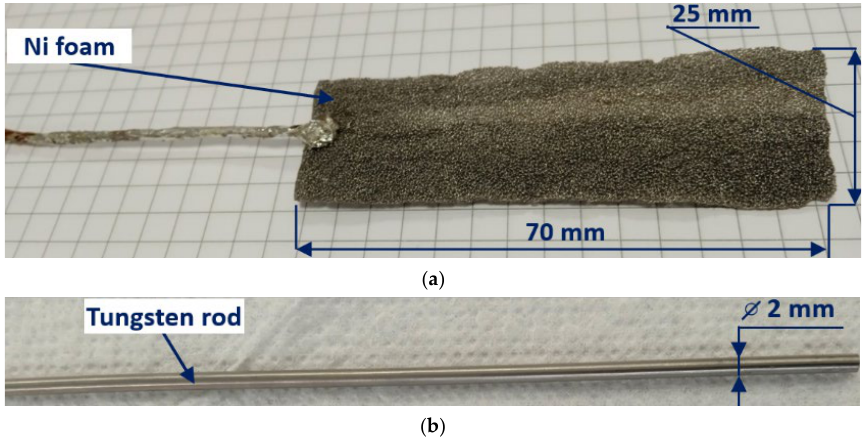
Figure 3. Ni foam anode ( a ) and tungsten cathode ( b ) used in the PDSE reactor. The DC voltage was supplied from the power source, which consisted of the LTC- 300-8D (Rucelf, Kolomna, Russia) variable autotransformer of 2.4 kVA nominal power equipped with a diode bridge and two smoothing capacitors of 16 mF (Kemet, Fort Lauderdale, FL, USA) providing the electrolytic cell with the rippled DC voltage. The instantaneous discharge voltage was measured using a WAD-A-MAX-608 (Acon, Lismore, Australia) voltage probe, while the instantaneous discharge current was measured using the voltage drop across a resistor of 1.5 mOhm using a WAD-A-MAX- 609 (Acon) precision isolation amplifier. All signals of the current and voltage probes were recorded using a WAD-AD12-128H (Acon) data logger. The data acquisition frequency was set at 100 kHz for each probe. The electric energy consumed by the autotransformer of the DC power supply was additionally measured by the KEW 5020 (Kyoritsu, Tokyo, Japan) 3-channel logger. The PTFE lid also had an insert for installing a HEL-705 (Honeywell, Charlotte, NC, USA) Pt-1000 resistance temperature detector (RTD) to measure the electrolytic solution temperature within the reactor, two fittings for connecting to a GM520 (Benetech, Palo Alto, CA, USA) digital differential pressure gauge (DPG) to measure the pressure differ- ence between the anodic and cathodic chambers, and four fittings with hoses equipped with needle valves to purge the gas products from the anodic and cathodic chambers. The coiled tube heat exchanger was applied to condense water vapor from the ca- thodic gas–vapor mixture prior to the measurement of the volume flow rate of the ca- thodic gas and gas chromatography. Cooling to 0 °C was achieved with a CC-K6 (HUBER) circulation thermostat. Additionally, two separators were installed after the condenser.